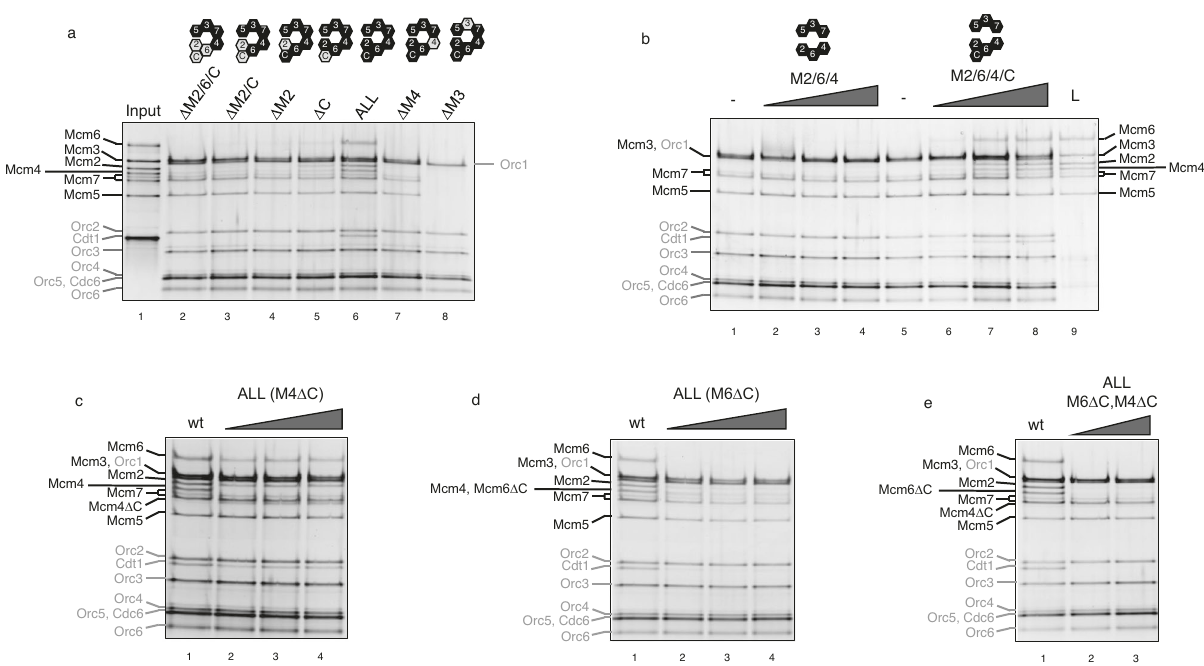
Fig. 2 Cdt1 and C-WHDs of Mcm4 and 6 are required for half MCM recruitment. a Recruitment by the OC complex, starting with the tetramer Mcm5/3/ 7/4 (lane 2) up to the full heptameric MCM-Cdt1 complex (lane 6). The missing MCM-Cdt1 subunits, in lanes 2 – 5 and 7 and 8, are labelled with Δ symbol and displayed as grey hexamers in the cartoon, while black hexamers indicate the subunits present in the assay. Negative controls of the MCM-Cdt1 recruitment are shown in lanes 7 (minus Mcm4) and 8 (minus Mcm3). 20% of the MCM-Cdt1 subunits used in the assay are shown in lane 1. b Two halves of MCM, Mcm5/3/7 and Mcm2/6/4, were isolated from gel fi ltration in separate runs and they were added separately and tested for recruitment. A constant amount of Mcm5/3/7 was used in combination with an increasing amount of Mcm2/6/4, without or with Cdt1 (lanes 2 – 4 and 6 – 8, respectively). The MCM-Cdt1 recruited in lane 8 was also tested for loading (ATP and high salt wash) (L, lane 9). c Recruitment of the MCM-Cdt1 either with Mcm4 wt (lane 1) or with increasing amounts of Mcm4 that lacks its C-WHD (M4 Δ C, lanes 2 – 4). d The same as c but with Mcm6 wt and Mcm6 lacking its C-WHD (M6 Δ C). e Recruitment of MCM-Cdt1 where both M6 Δ C and M4 Δ C are included. See also Supplementary Figs. 3 and